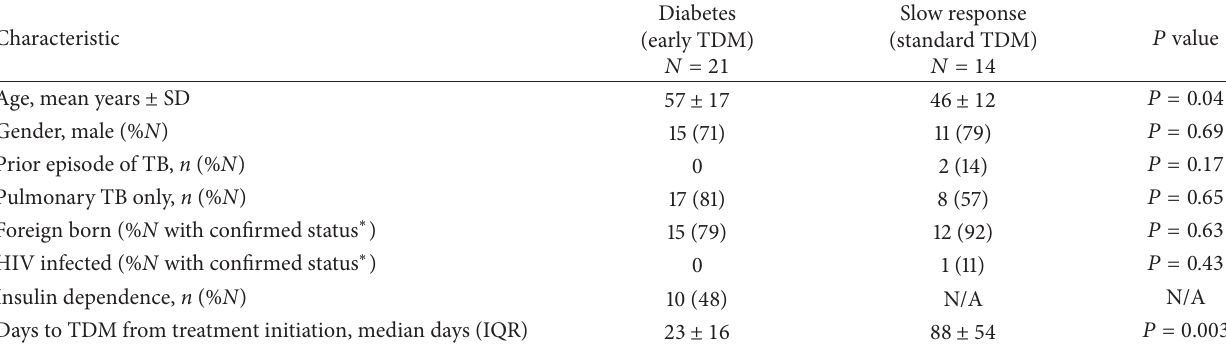
Table 1: Baseline characteristics of adults with drug-susceptible tuberculosis referred for therapeutic drug monitoring (TDM) based on slow response or early TDM if